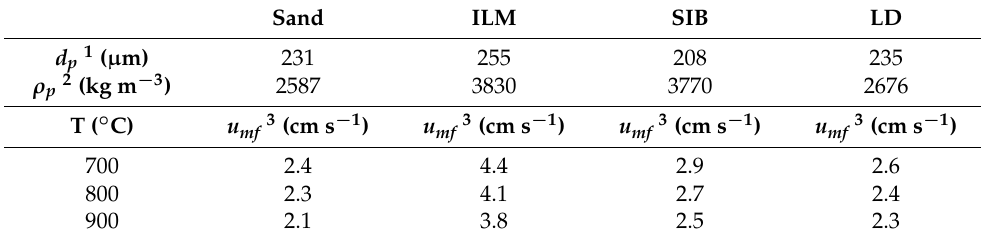
Table 1. Properties of fluid-dynamic interest and related minimum fluidization velocities of all bed materials, as functions of temperature (adapted from [12] for the